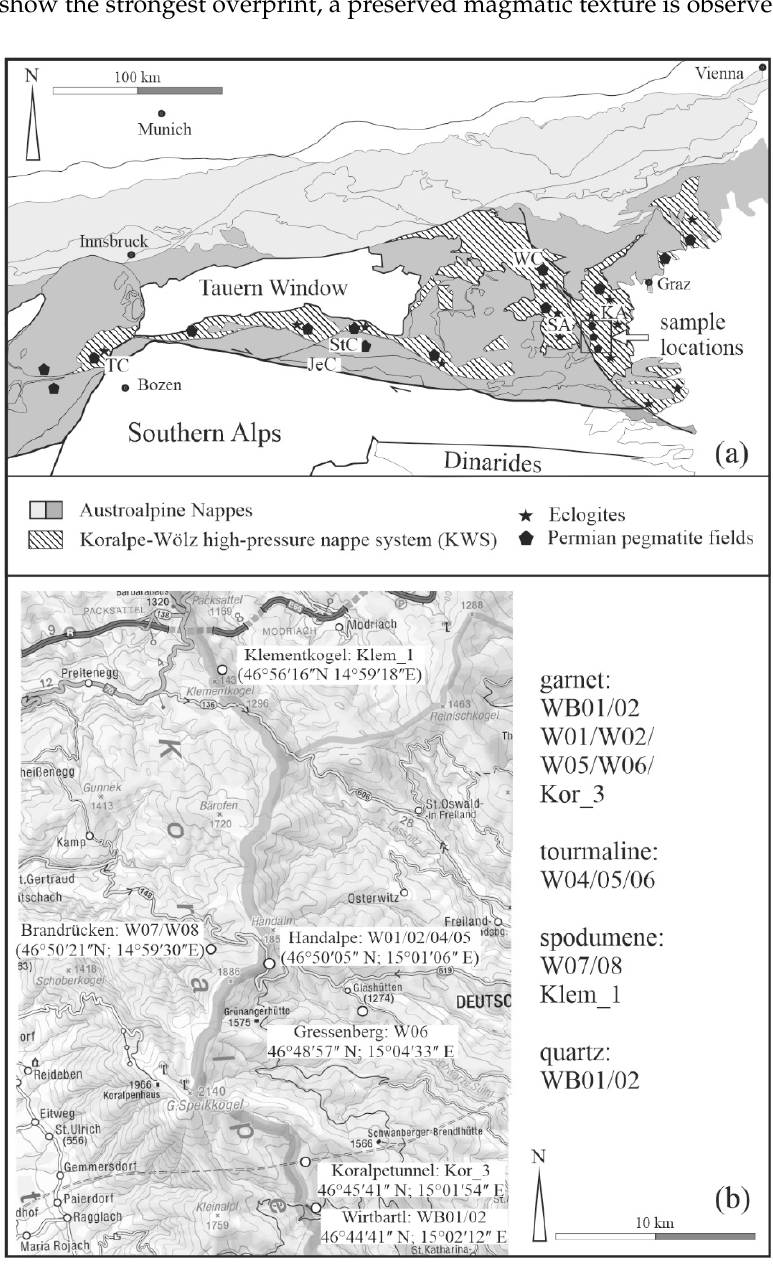
Figure 1. ( a ) Simplified geological map of the Eastern Alps showing W–E extent of the Koralpe-Wölz high-pressure nappe system (hatched areas) and approximate locations of Eoalpine eclogites (former Permian gabbros) and Permian pegmatite fields (map modified after Schmid et al. [10]). Note, that pegmatites occur also south and west of the wedge. The location of pegmatite samples in the Koralpe (KA) is indicated. Abbreviations: TC: Texel Complex; StC: Strieden Complex; JeC: Jenig Complex; WC: Wölz Complex; SA: Saualpe Complex; KA: Koralpe Complex. ( b ) Sample locations near the borderline between Styria (east) and Carinthia (west) given by GPS data. Sample numbers for the studied inclusions in host minerals are given in the column to the right. Topography taken from Amap Online